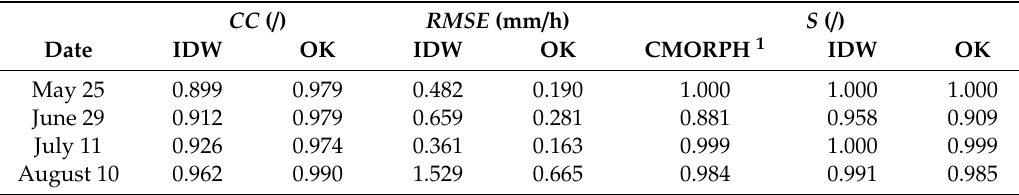
Figure 4. The comparisons of reconstructed- and synthetic rainfall field: 17:00, 25 May 2019; 8:00, 29 June 2019; 23:00, 11 July 2019 and 1:00, 10 August 2019 Table 2. The evaluation metrics of reconstructed rainfall fields from OELs network based on inverse distance weighting (IDW) and ordinary kriging (OK) interpolation